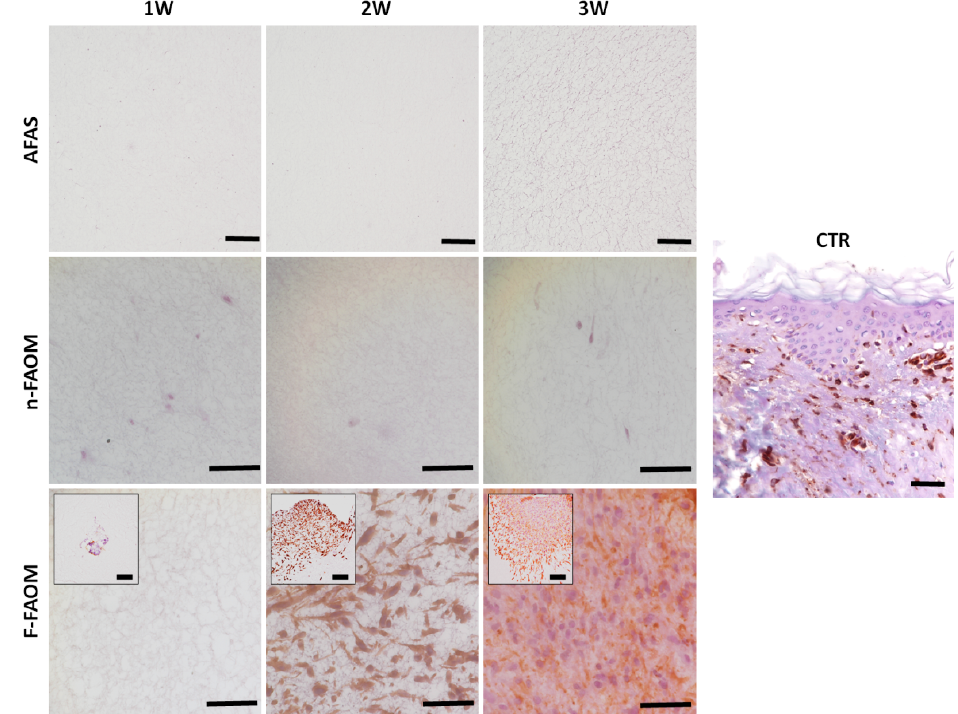
Figure 2. Immunohistochemical analysis of controls and biofabricated oral tissues using